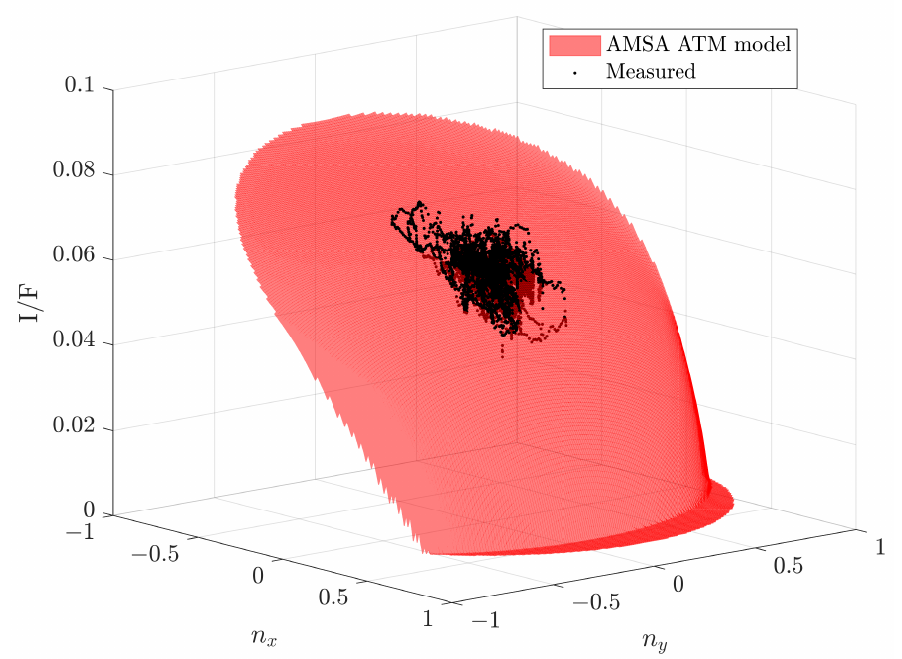
Figure 6. The estimated best fit model with atmospheric parameters is displayed in red and the measured I/F values for the normal vectors based on the initial DEM are represented by the black dots. The x-axis represents the x-component of the normalized normal vector and the y-axis represents the y-component of the normalized normal vector based on the initial DEM. Line patterns in the black point cloud are the result of stereo artifacts in the initial